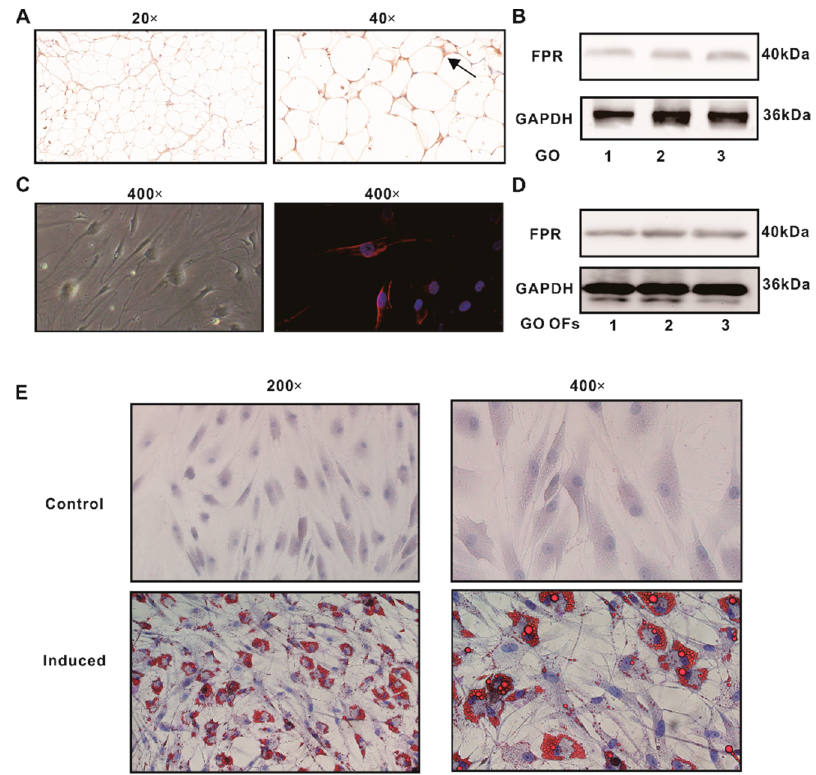
Figure 1. The expression of the FPR and adipogenic differentiation of the OFs of GO patients. ( A ) Immunohistochemistry for FPR expression in the orbital adipose tissue of patients with GO. Arrowheads designate positive staining (brown color). ( B ) Protein expressions of the FPR detected in the orbital adipose tissue of patients with GO. ( C ) Immunofluorescence for FPR expression in GO OFs. ( D ) The protein expressions of the FPR detected in GO OFs. ( E ) The oil red O staining for the control and induced groups.